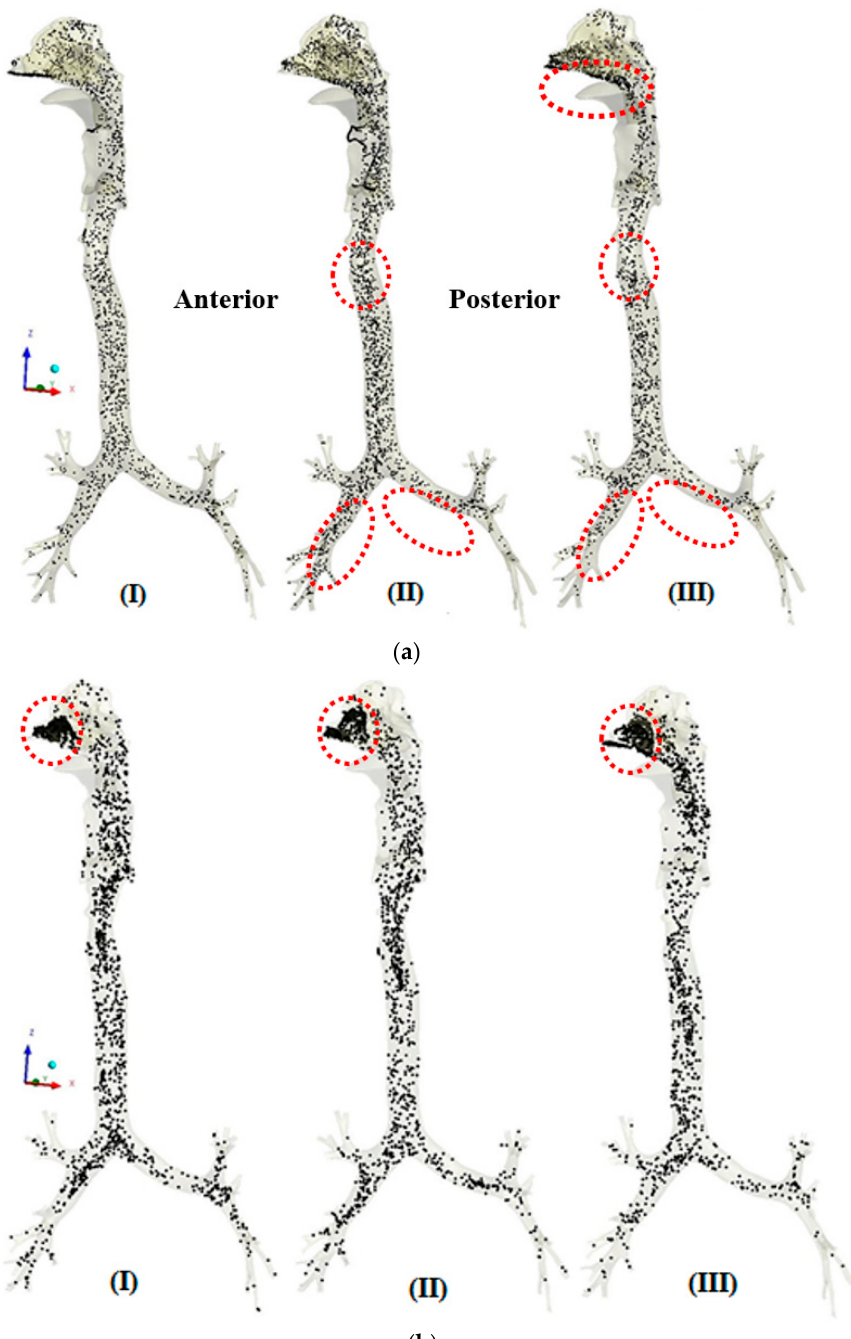
Figure 4. ( a ) Transport pattern of PM 2.5 during normal inspiration. ( b ) Transport pattern of PM 10 during normal inspiration.